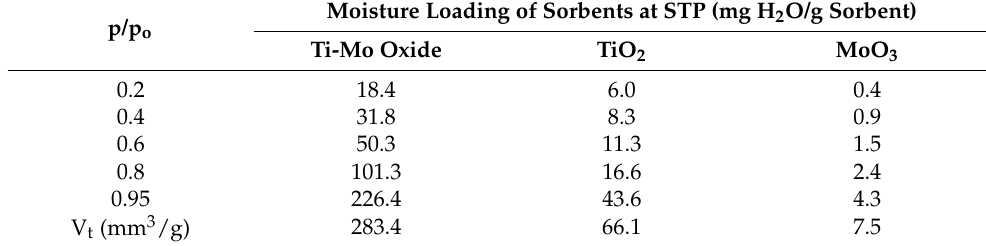
Figure 8. Sorption of water isotherms for the pure oxides and Ti-Mo NC. Table 2. Moisture loading of sorbents at various relative humidity